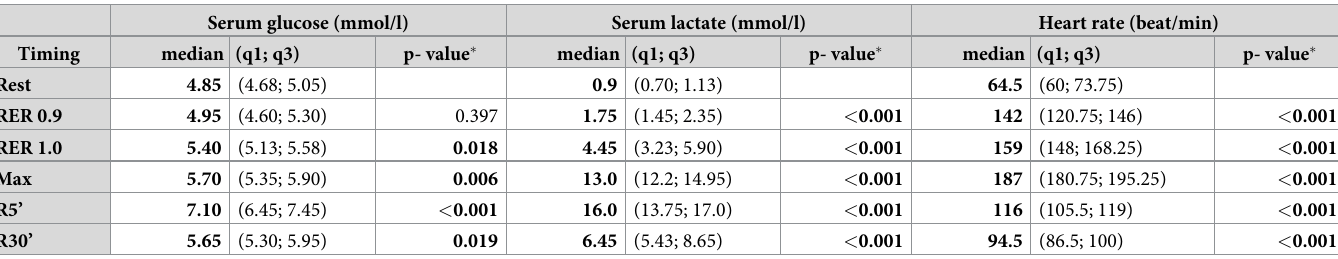
Table 3. Blood glucose and lactate concentration during the short protocol.